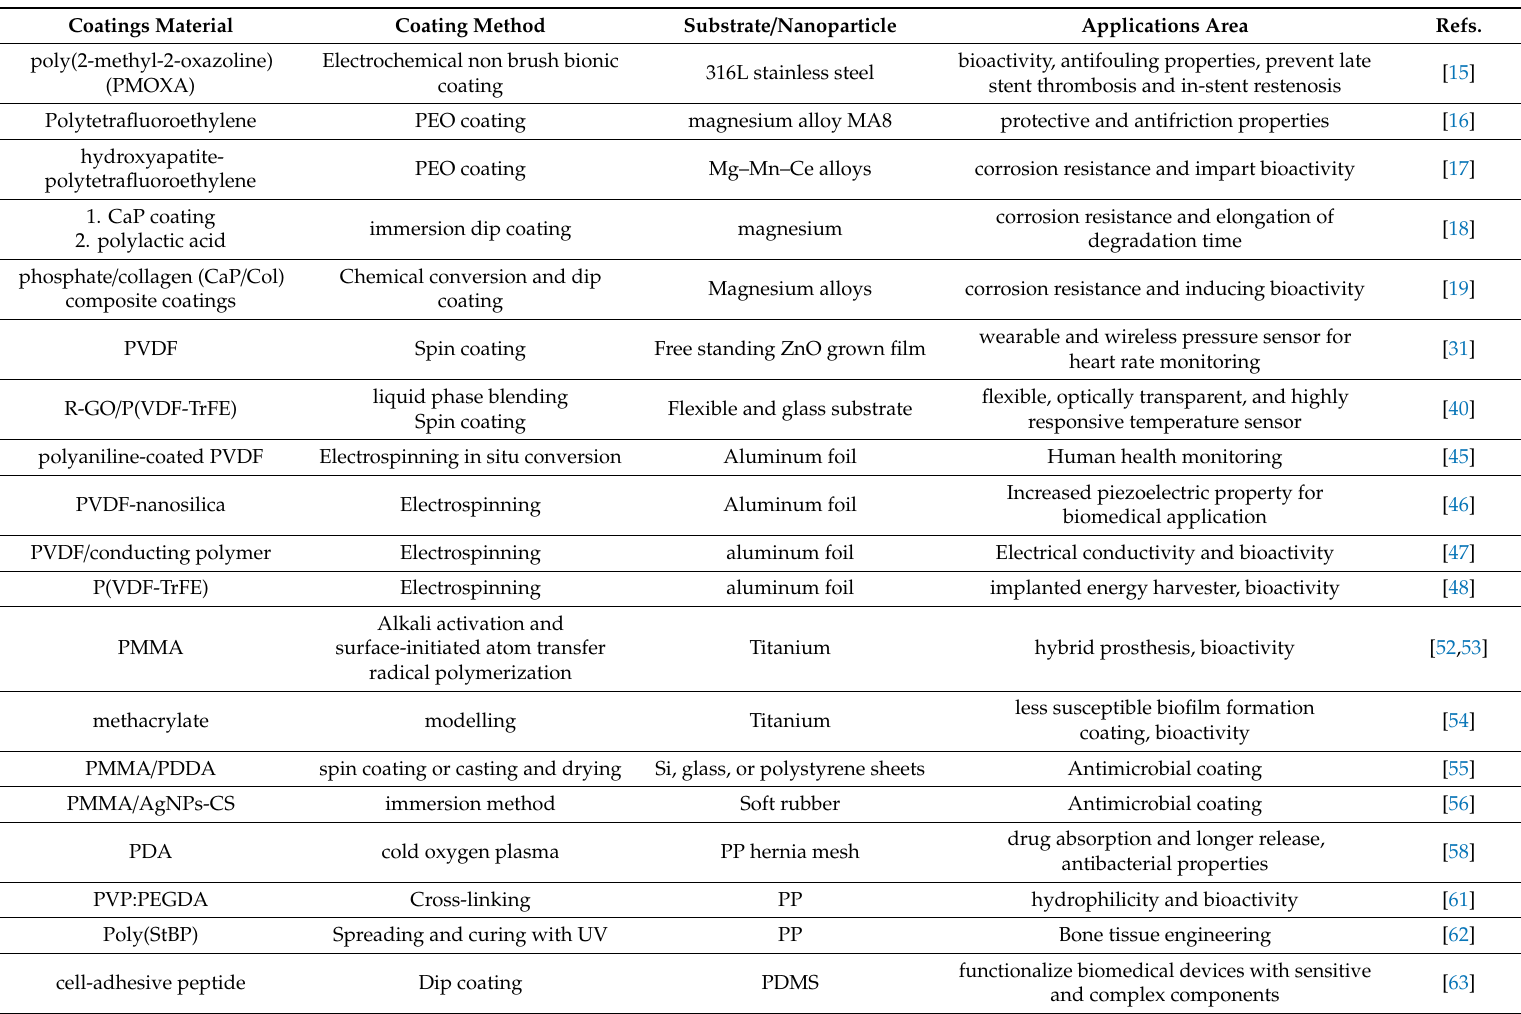
Table 1. Summary of the polymer coatings for biomedical